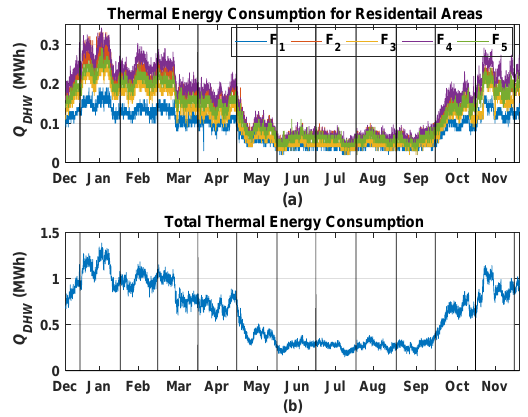
Figure 3. ( a ) Yearly Q DHW consumption pattern of all feeders. ( b ) Total yearly Q DHW consumption pattern of all